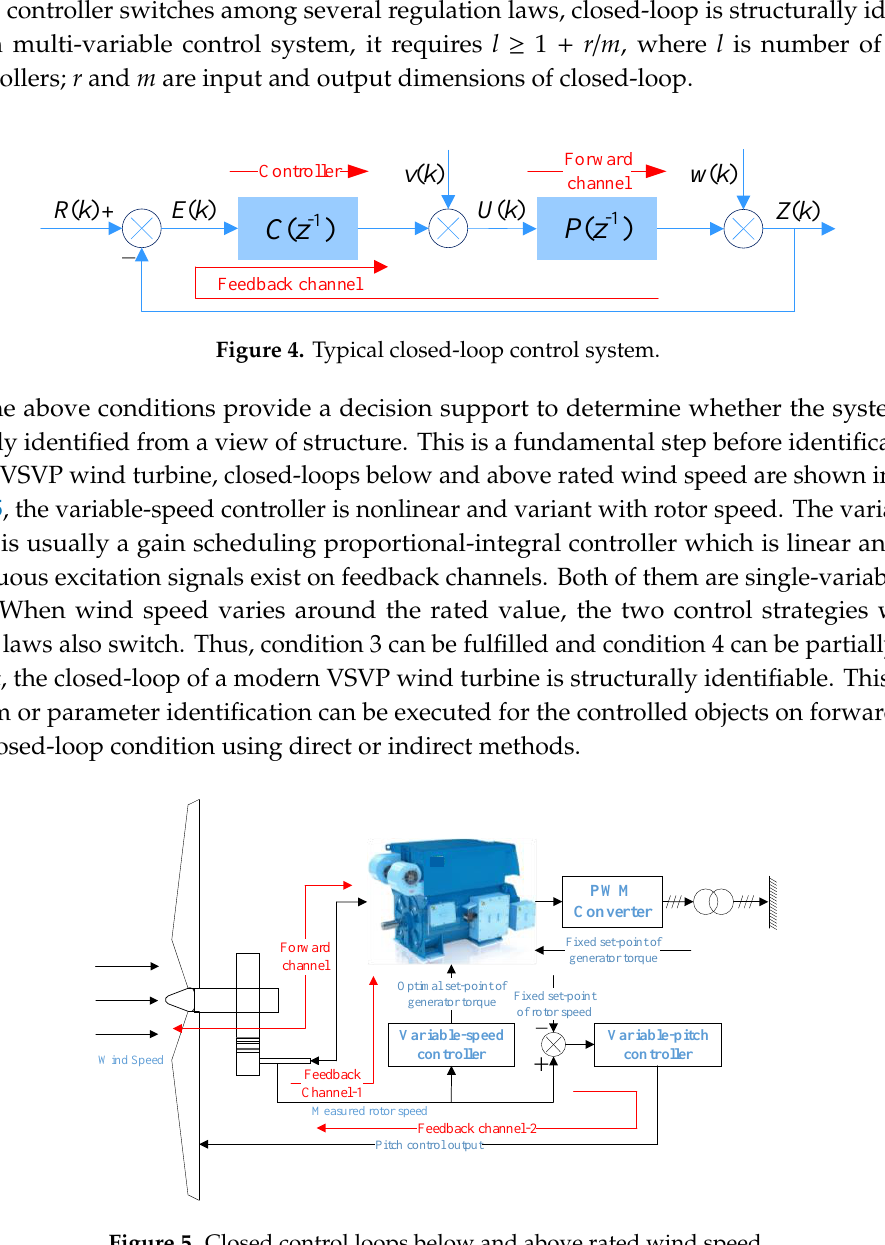
Figure 5. Closed control loops below and above rated wind speed.